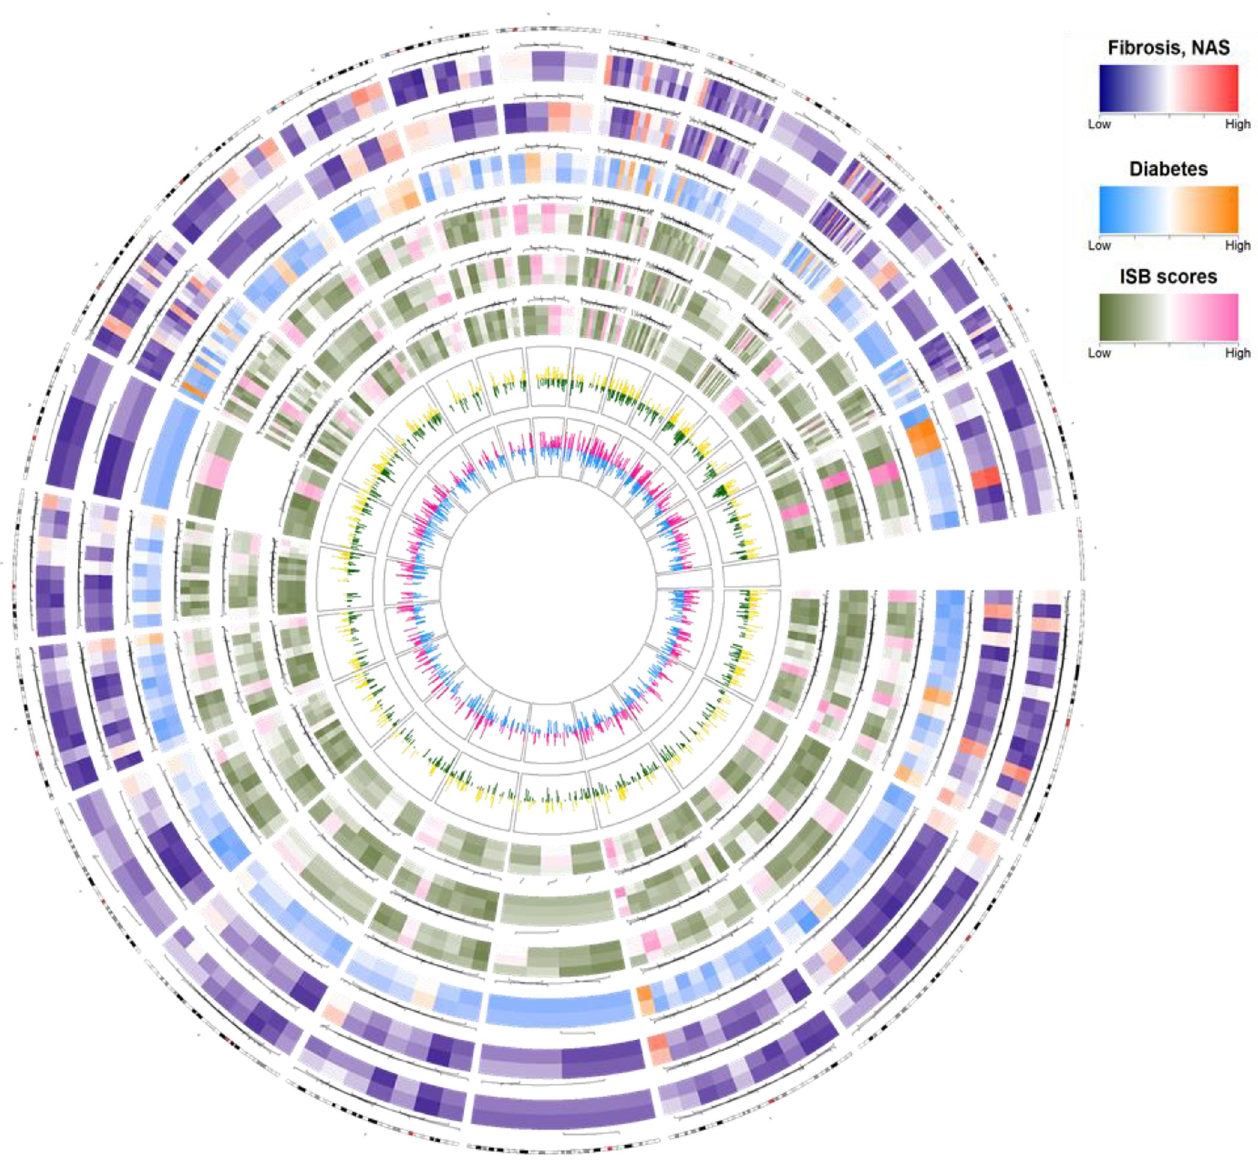
Fig 3. Circos plot presenting the summary of miRNA expression and correlation patterns in 41 patients. The Circos plot consists of eight tracks, containing six heatmaps for six variables (fibrosis, nonalcoholic fatty liver disease, diabetes, inflammation score, steatosis score, and ballooning score); the two peaks indicate the correlations between miRNAs and two clinical parameters (ALT, alanine aminotransferase; PLT, platelet). The six variables are represented by colors according to high (red, orange, and pink) or low (blue, sky blue, and green) expression. Three variables (inflammation score, steatosis score, and ballooning score) are represented as I, S, and B in the color key. Each variable was grouped into two or three categories of low or high scores or values (fibrosis stage, 0–2 versus 3 and 4; NAS < 5 versus � 5; diabetics, yes versus no; inflammation score 1 versus 2 versus 3; steatosis score 1 versus 2 versus 3; ballooning score 0 versus 1 versus 2). Differences between the mean values of each dataset for the six variables were obtained. Differences in the mean values for each dataset were obtained from the expression levels of 2,576 miRNAs, and the top 200 miRNAs were plotted in the heatmap of the Circos plot. The positioning of each heatmap represents the genomic location of the miRNA, and the color represents the average expression level in patients belonging to each score of each variable. The outer yellow or red indicates a positive correlation between ALT or PLT and miRNA expression, and the inner green or sky blue indicates a negative